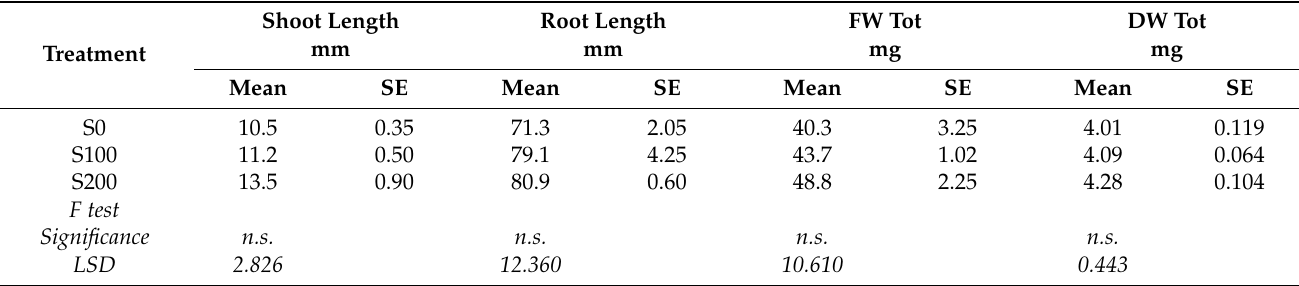
Table 3. Individual growth parameters of sprouts obtained from seeds harvested from mother plants grown under the three salinity treatments S0, S100 and S200 (i.e., 0, 100 and 200 mM of NaCl in the solution used for watering the pots throughout the whole growing cycle). SE is the standard error.